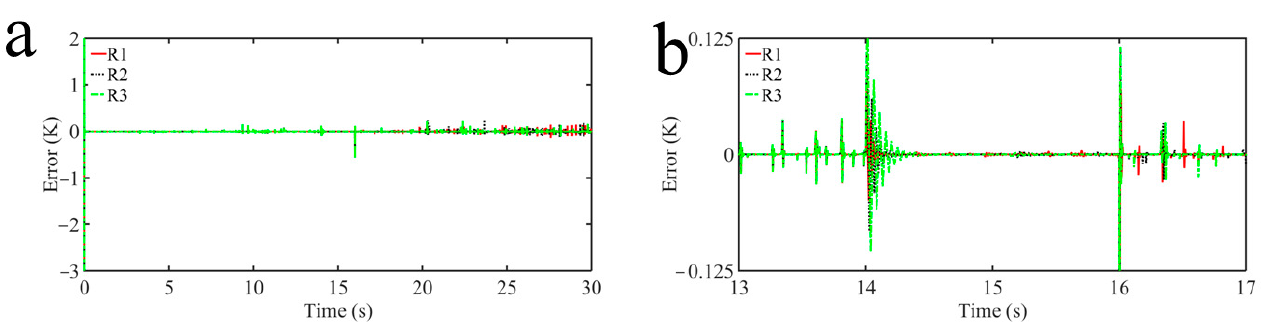
Figure 30. Simulation results with some external disturbances: ( a ) the tracking errors of Wall 2_5 mm for composite controller; ( b ) their partial enlarged figures in details.